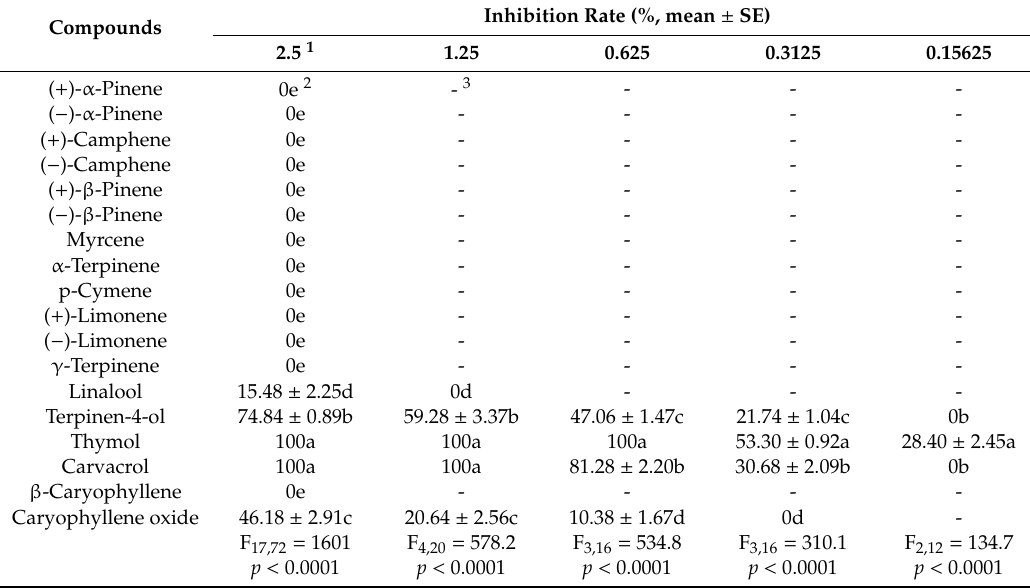
Table 5. Fumigant antifungal activities of constituents from summer savory and thyme white essential oils against R. quercus-mongolicae